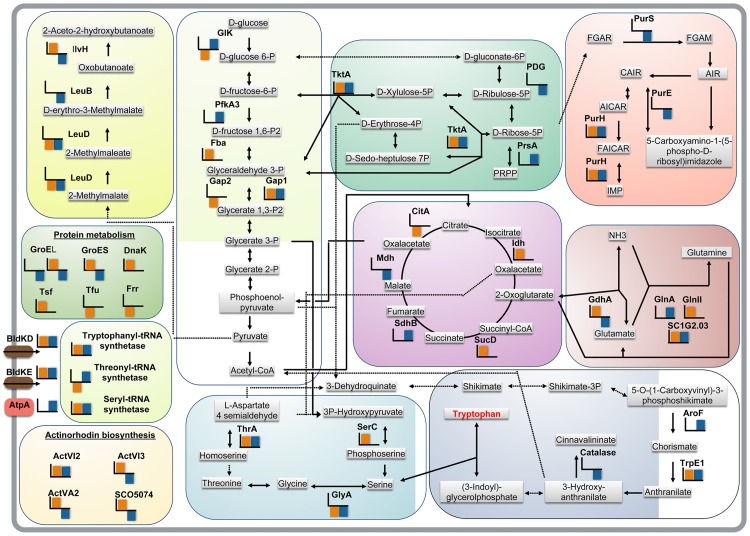
Global view of the metabolic pathways affected by trpM deletion.Metabolic pathways involving proteins over- and under-represented in 2038KO cultivated on MM vs WT cultivated on MM and in 2038KO cultivated on MM vs 2038KO cultivated on MM-Trp are shown with orange and blue bar color, respectively.